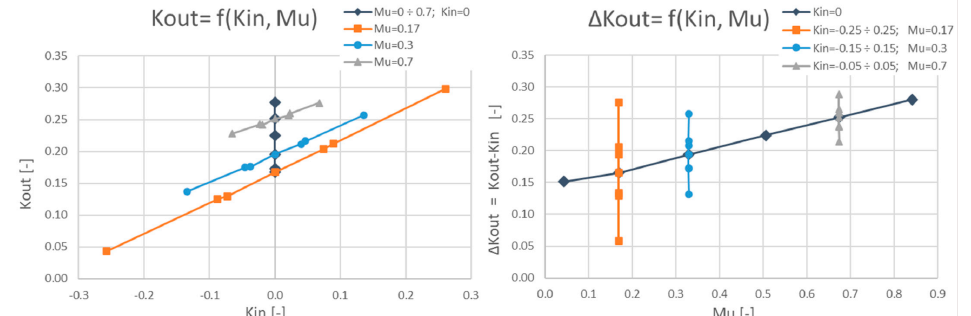
Figure 6. Exit swirl ratio dependency on M u and K in .